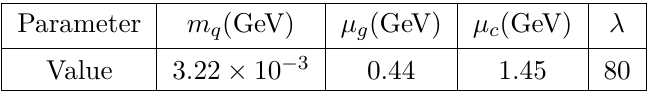
Table 1 . The parameter values taken from ref. [66]. With the giving parameters, the light meson spectra, which are consistent with the experimental data, can be solved and the chiral phase tran- sition is also well described.